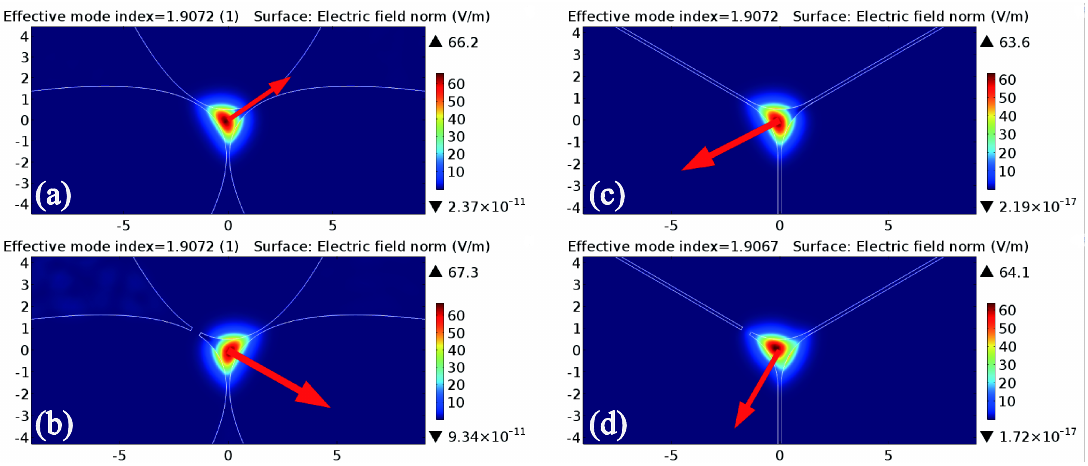
Figure 5. Influence of suspension arm defects on two kinds of SCFs. ( a ) Proposed SCF without structural defects; ( b ) proposed SCF with structural defects; ( c ) traditional SCF without structural defects; ( d ) traditional SCF with structural defects.